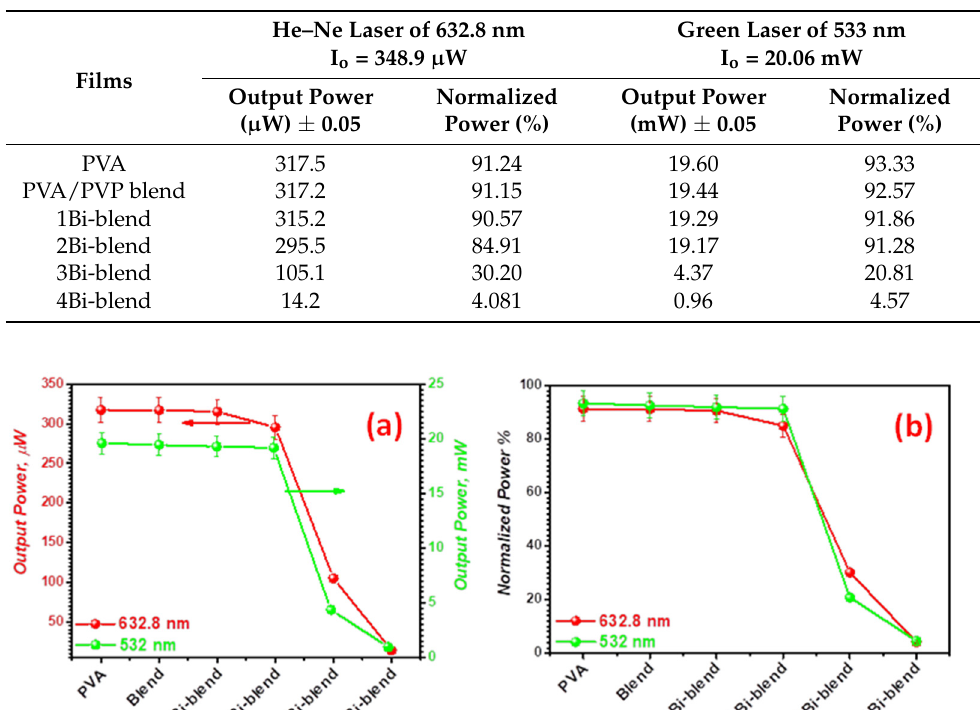
Table 3. Optical limiting parameters for Bi-blend hybrid samples.